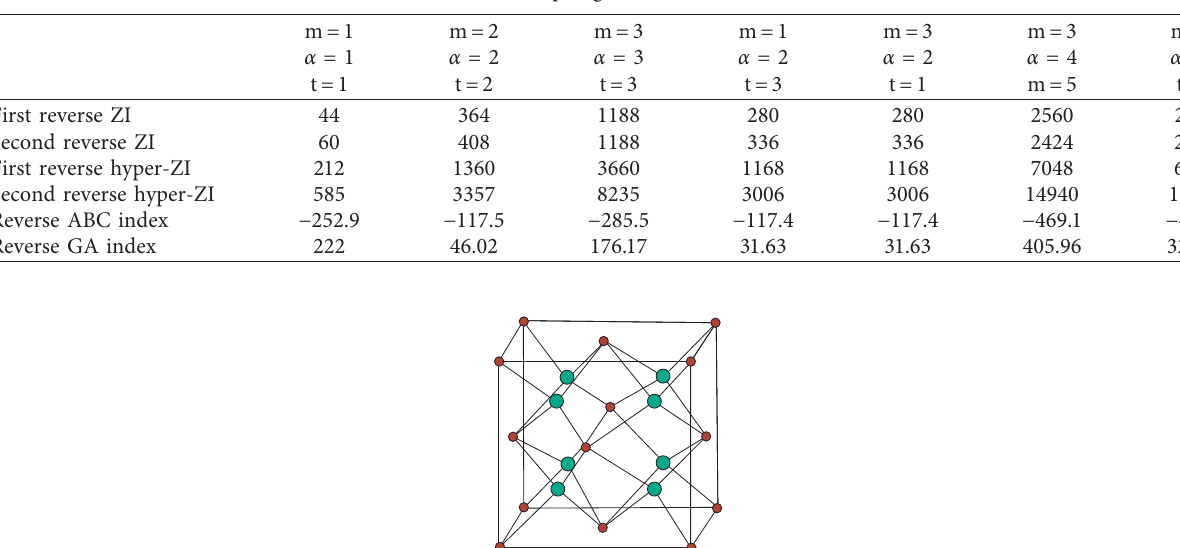
2 O at different levels.